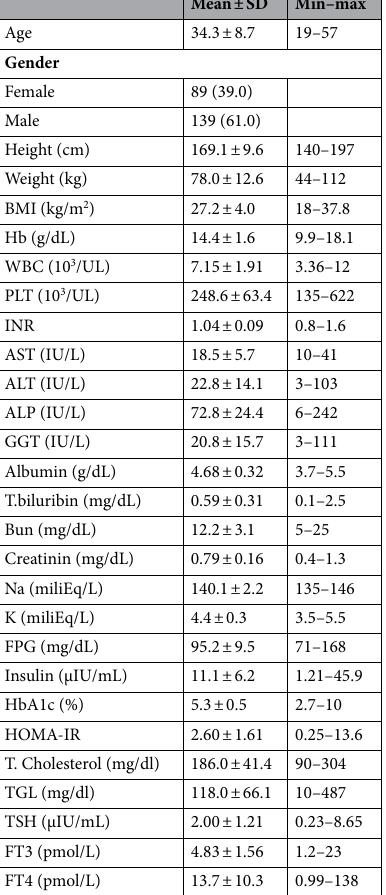
Table 1. Laboratory findings and general demographic characteristics of study population. BMI Body mass index, cm centimeter, kg kilogram, Hb Hemoglobin, WBC white blood cell, PLT platelet, INR international normalized ratio, AST aspartate aminotransferase, ALT alanine aminotransferase, GGT gama glutamyl transpeptidase, ALP alkaline phosphatase, Na sodium, K potassium, FPG fasting plasma glucose,